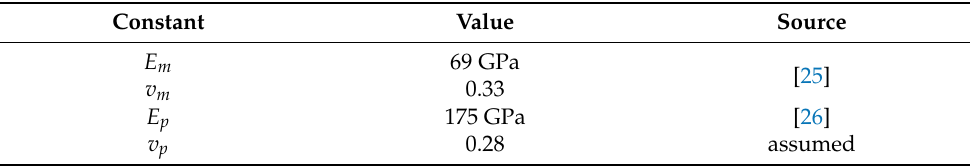
Table 2. Young’s modulus and Poisson ratio for aluminum matrix and α -Al(Mn, Fe)Si precipitate. The subscripts m and p indicate matrix phase and precipitate.